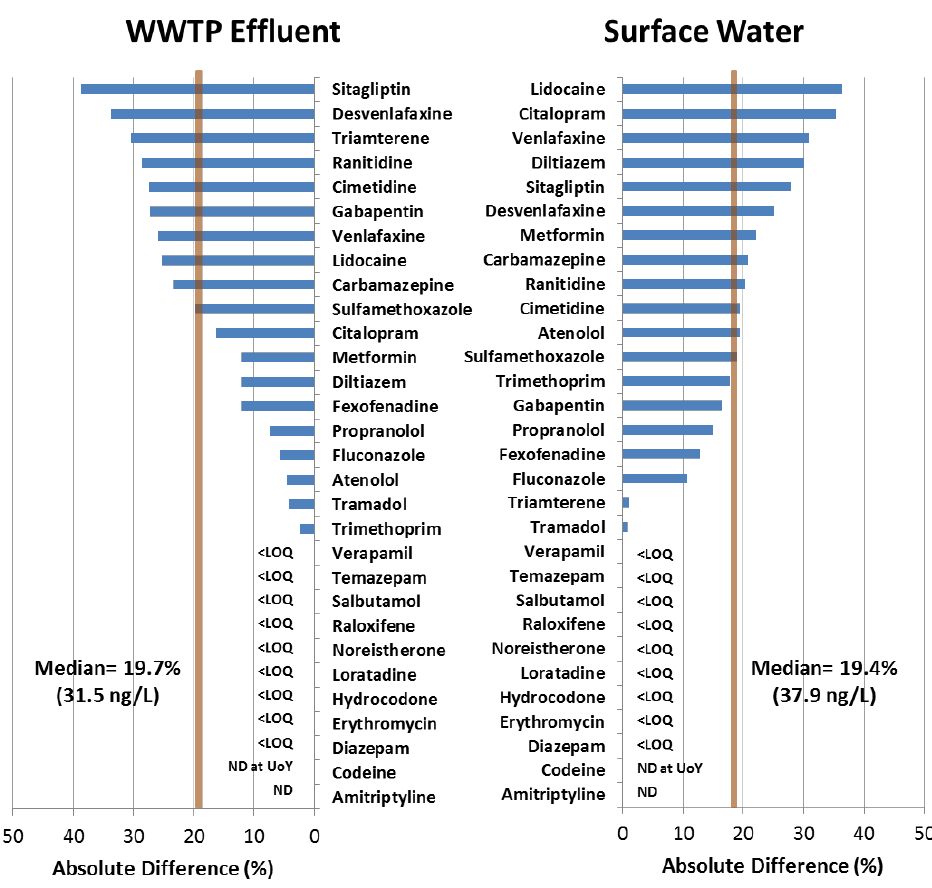
Figure 3. Relative percent difference (RPD) between concentrations of 30 medicinal chemicals (present in both respective methods) quantified by the USGS (using USGS method No. 5-B10 [7]) and CoEMS (using the method presented in this work) in both WWTP effluent and surface water with median RPD represented by the vertical bar.